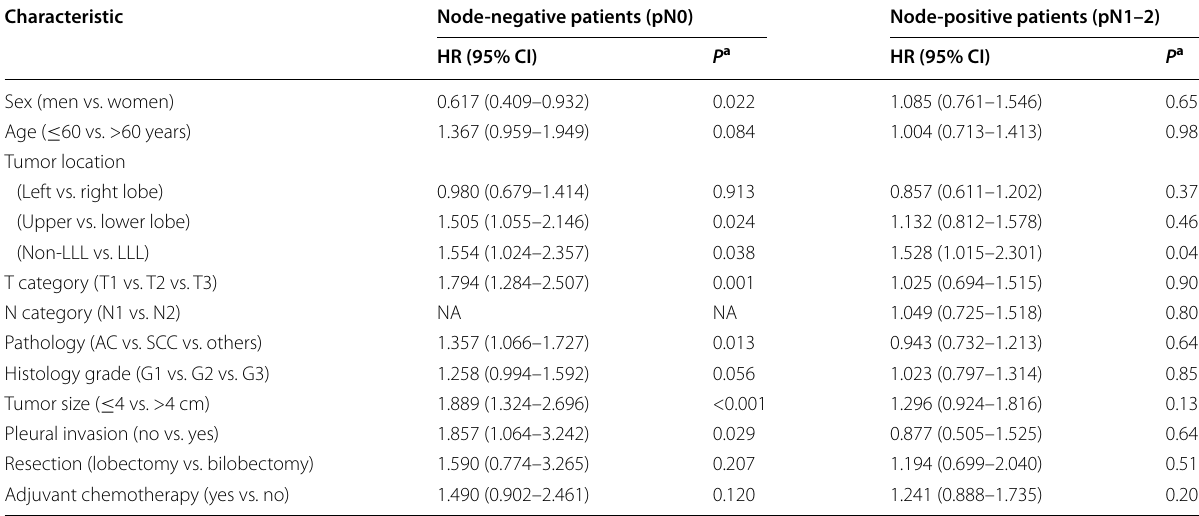
Table 3 Univariate analysis for NSCLC patients with or without lymph node